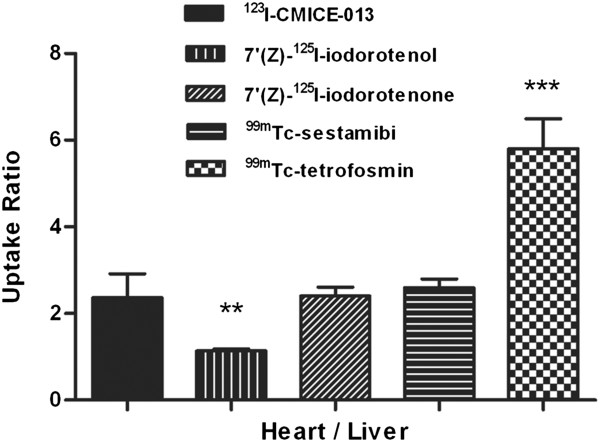
Heart/liver ratio of 123I-CMICE-013 versus other perfusion agents. The heart/liver ratio of 123I-CMICE-013 at 62 min (approximately 1 h) was compared to that of 7′(Z)-125I-iodorotenol, 7'(Z)-125I-iodorotenone, 99mTc-tetrofosmin, and 99mTc-sestamibi [12,13]. The ratio of 123I-CMICE-013 was expressed as mean ± SD (n = 6); 7'(Z)-125I-iodorotenol, 7'(Z)-125I-iodorotenone as mean ± SD (n = 3, 7); and 99mTc-tetrofosmin, 99mTc-sestamibi as mean ± SEM (n = 5, 5). ** P < 0.001, *** P < 0.0001 versus 123I-CMICE-013.